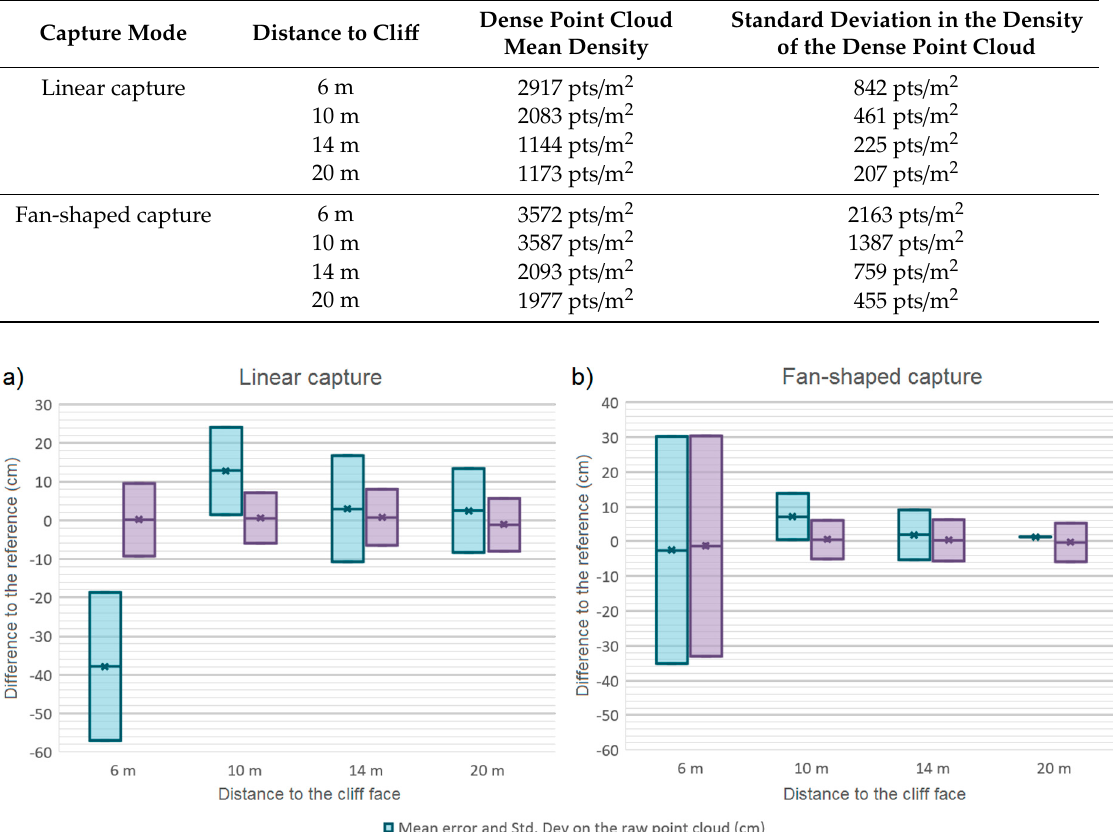
Table 3. Mean density and standard deviation obtained on the dense point clouds reconstructed for di ff erent survey protocols.